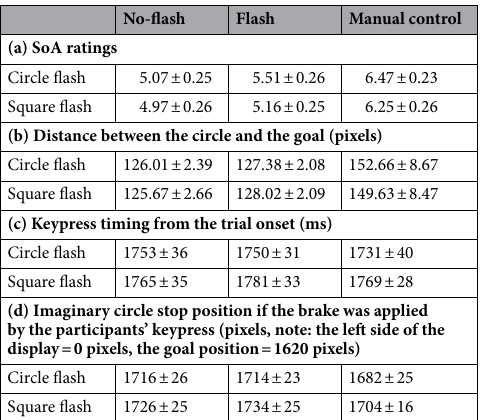
Table 2. Results in experiment 2. Mean ± SE. The values in Manual control are shown as reference information and not